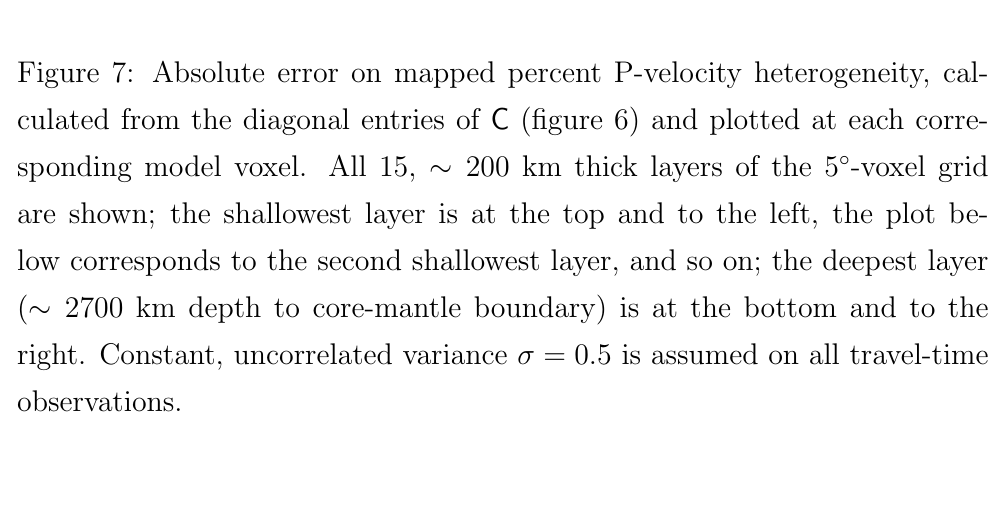
Figure 6: 24 , 840 × 24 , 840 (5 ◦ -voxel grid) covariance matrix C associated with the same data, parameterization and regularization as R above, defined as in section 5, and derived by Cholesky factorization and backsubstitution.